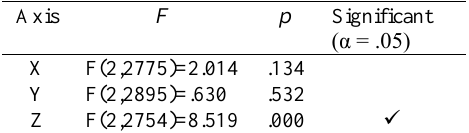
Table 5. Significance of the effect of head position on precision